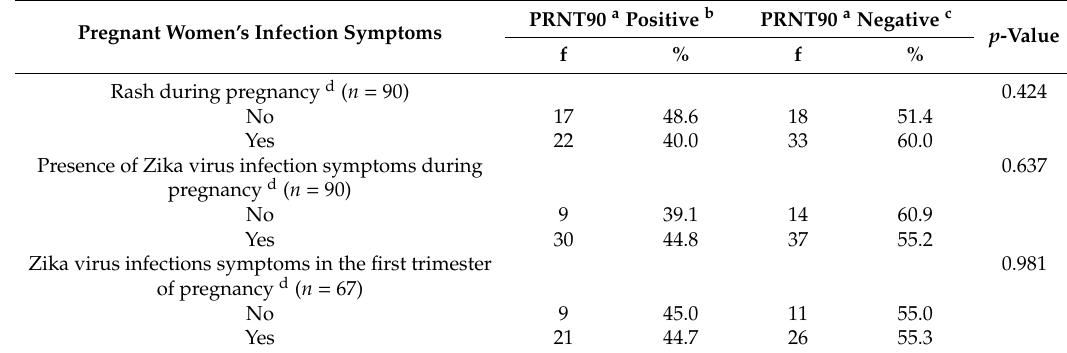
Table 2. Symptoms of infection in pregnant women and positive and negative plaque reduction neutralization test in children with Congenital Zika Virus (CZS). S ã o Lu í s, Brazil, 2016–2018. PRNT90 a Positive Pregnant Women’s Infection Symptoms